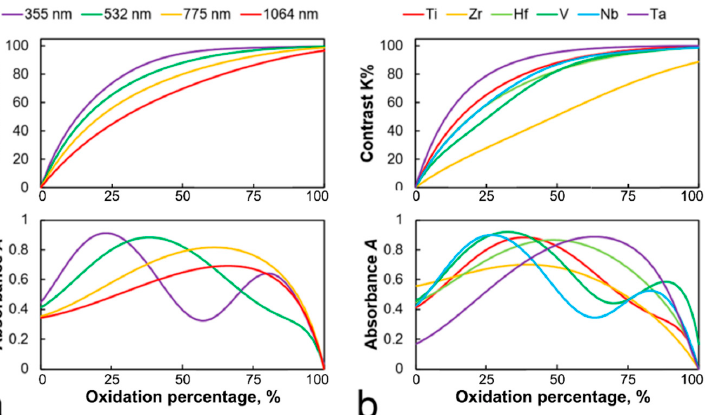
Figure 8. Dependence of the recorded structures contrast and the film absorption on the thickness of the oxidized layer (meaning that oxidation percentage equals to 0% for the initial metal film and to 100% at the through oxidation) ( a ) for different wavelengths of laser radiation for a 60 nm-thick Ti film and ( b ) for different 60 nm-thick films that were oxidized by a radiation with a wavelength λ = 532